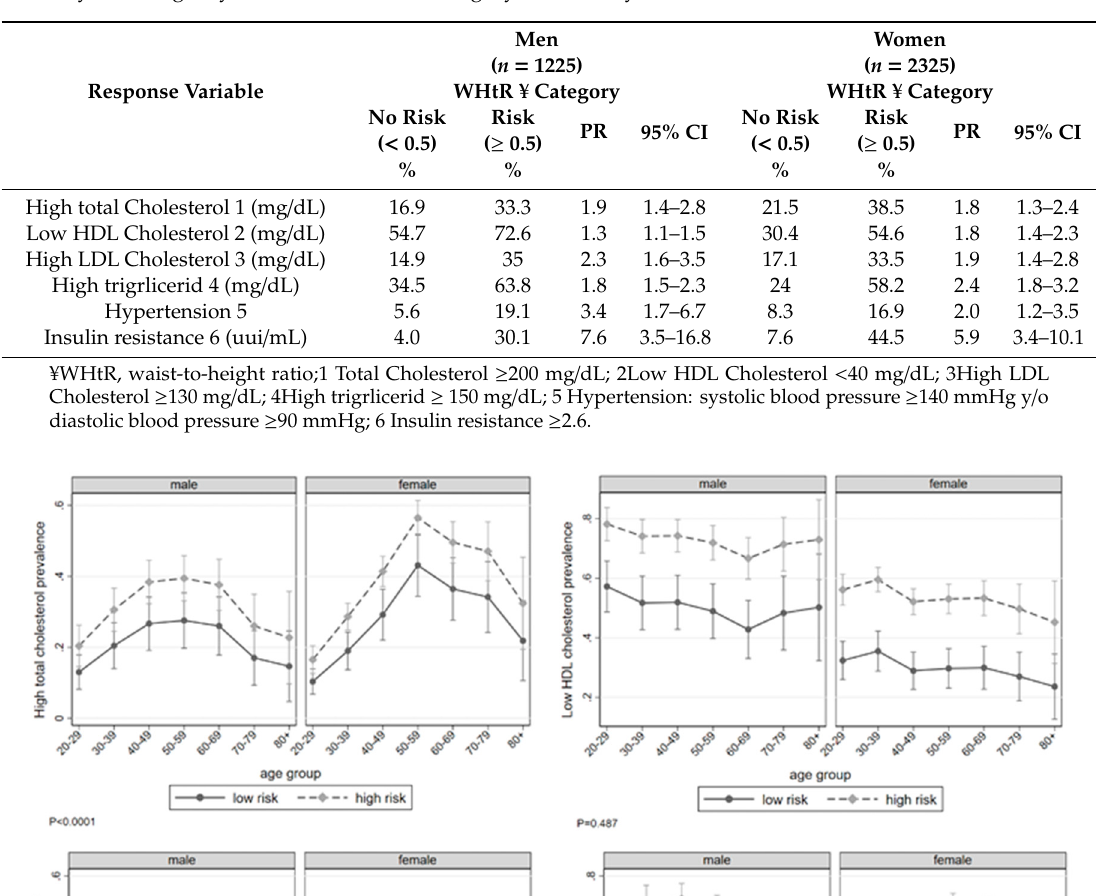
Table 3. Prevalence ratios by sex for dyslipidemia, hypertension and insulin resistance in adults over 20 years of age, by cardiovascular risk category assessed by ICE, ENSANUT MC 2016. Mexico, 2016.